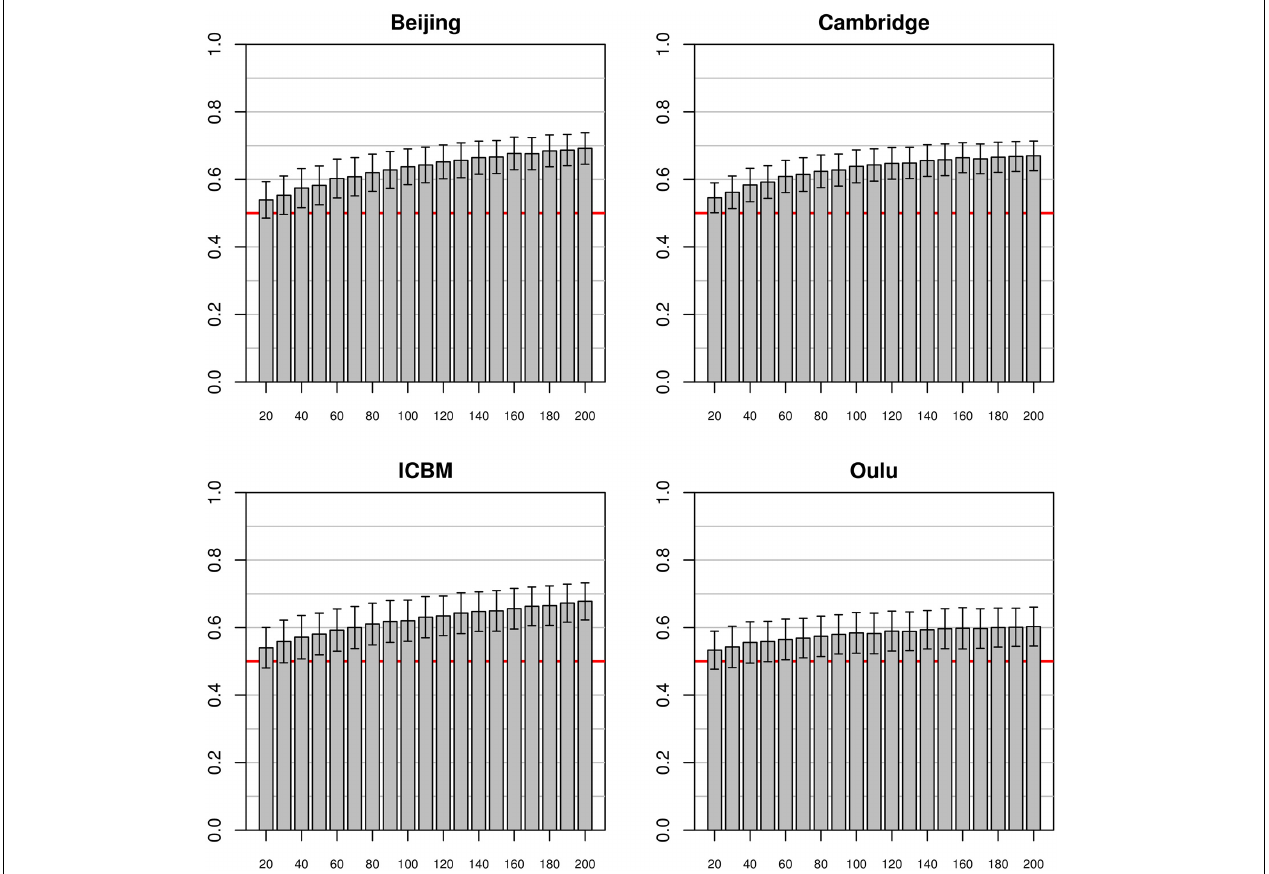
FIGURE 5 | Simulations using training datasets from the pooled sample and using subjects from a single study as test dataset. Bars and whiskers represent means and standard deviations of the test accuracies. Mean test